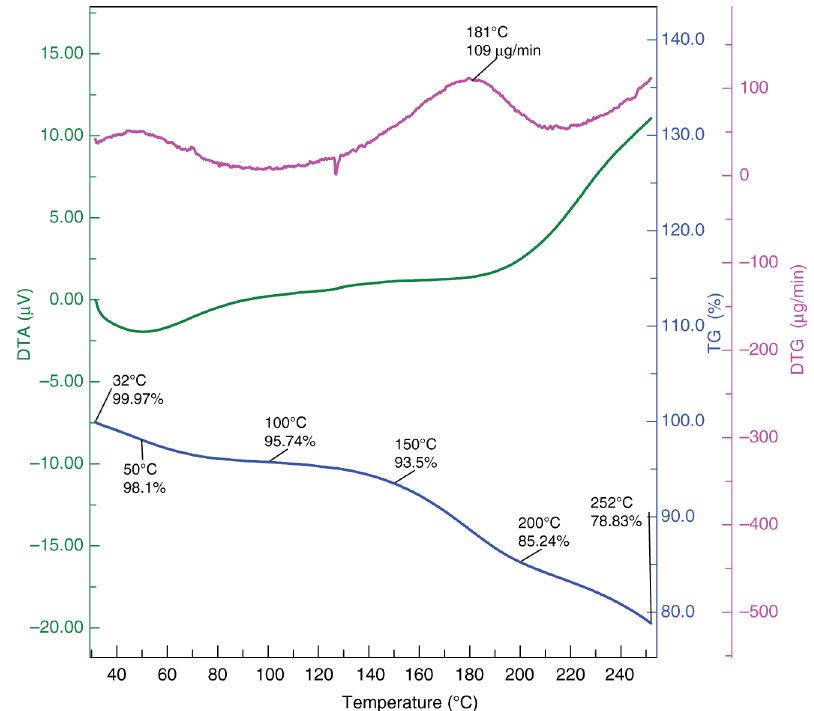
Figure 24: Thermal analysis of coated sample (15% fiber by